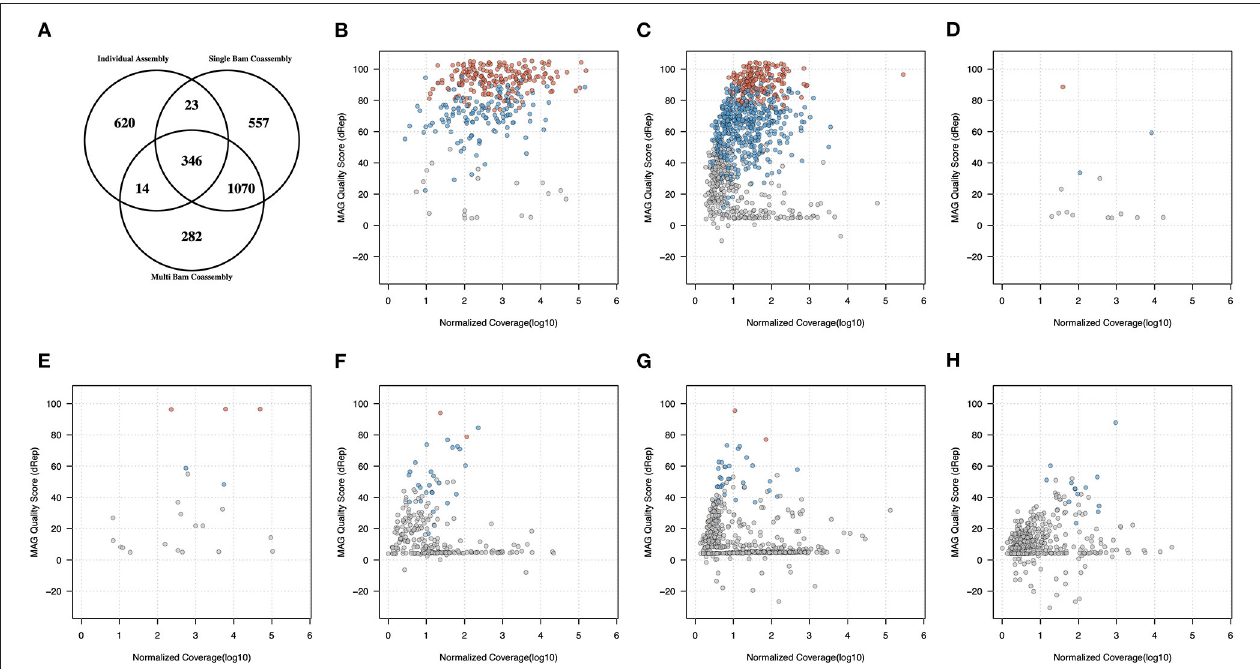
FIGURE 2 | Inter-relationships between genome quality, relative abundance and recovery workflow type for 7.138 MAGs recovered from the use of MetaBAT2. (A) secondary cluster membership by workflow 7,138 MAG categorised into 2,912 secondary clusters; the remaining panels show the highest observed genome quality with a secondary cluster (vertical axis) against normalised coverage measure (horizontal axis) for secondary clusters (B) containing MAGs from all three workflows ( n =346); (C) recovered from both single-BAM and multi-BAM co-assembly workflows ( n =1070); (D) recovered from both individual assemblies and multi-BAM co-assembly ( n =14); (E) recovered from both individual assemblies and single-BAM co-assembly ( n = 23); (F–H) recovered solely from multi-BAM co-assembly ( n = 282), single-BAM co-assembly ( n = 557) and individual assemblies ( n = 620), respectively. Secondary clusters containing pHQ, MQ, and LQ MAGs are coloured in red, blue, and grey,